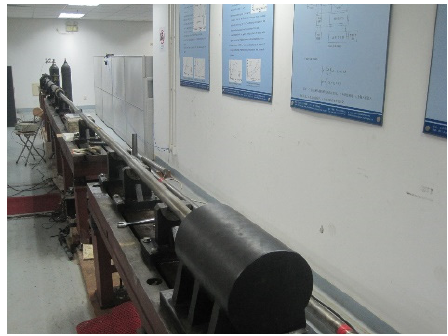
Figure 2. The SHPB experimental system. Table 1. Basic physical parameters of red